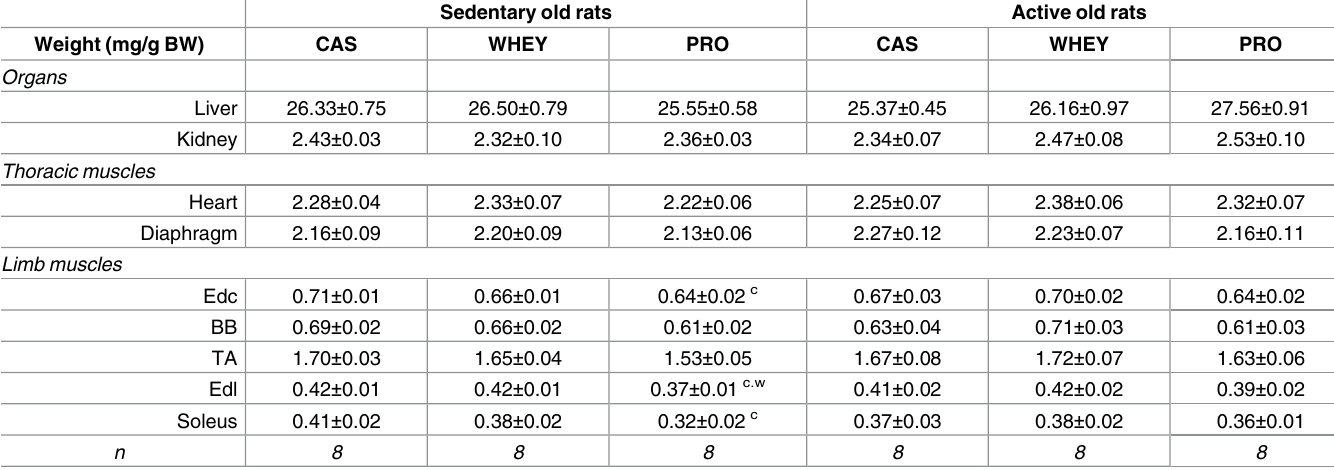
Table 9. PRO group exhibited lower limb muscle mass for the sedentary but not for the exercisedcondition.